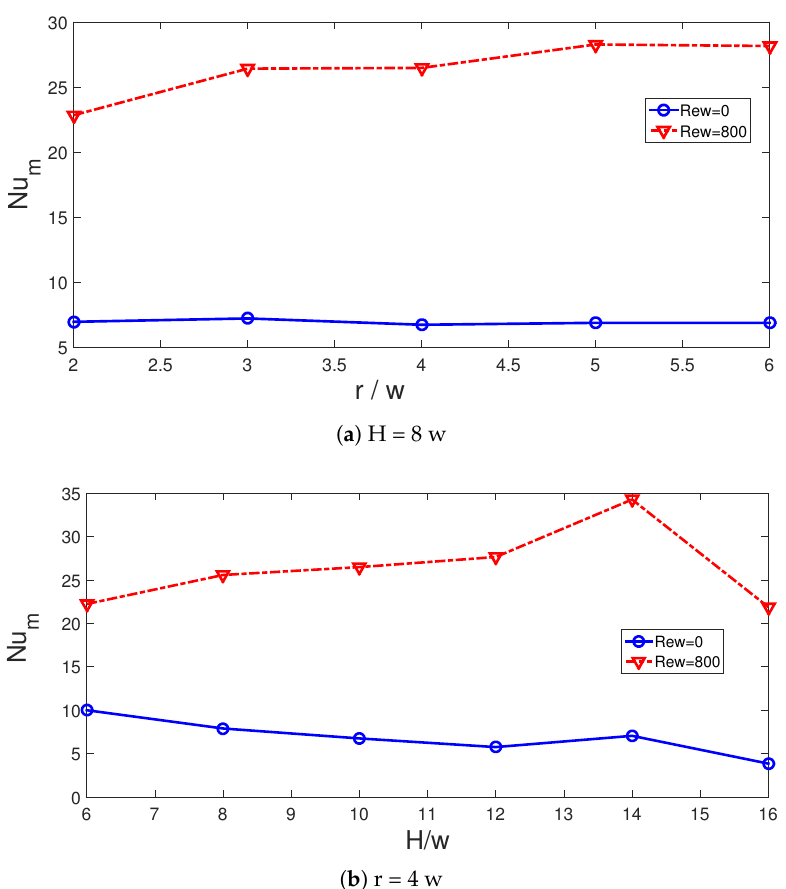
Figure 7. Average Nu variations with changes in size of the cylinder ( a ) and distance from the jets to interface boundary ( b ) (Re1 = Re2 = 300, Ha1 = 10, Ha2 =